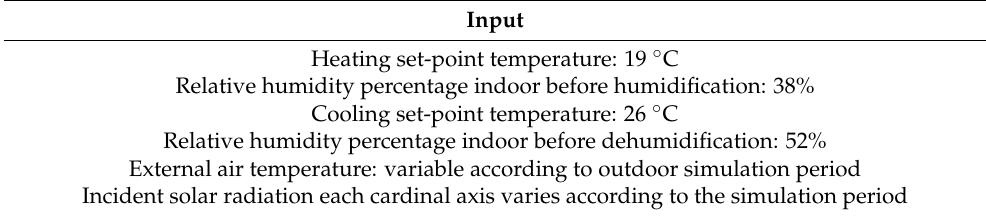
Table 5. TRNSYS input